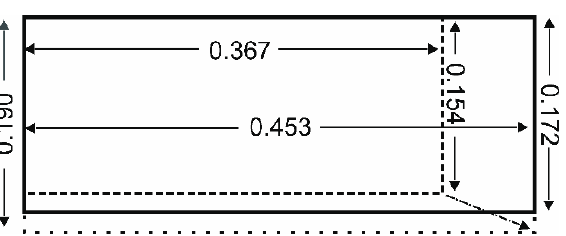
Figure 2. Comparison of wing shape in the two subspecies. The outline of the wing of T.f.pratincola is drawn by solid lines, that of T.f.punctatissima by dashed lines (original size) and by dotted